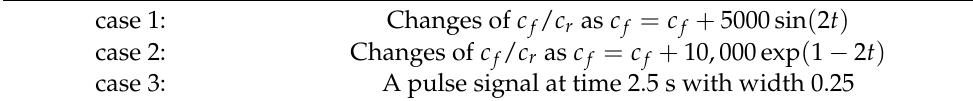
Table 4. Different external disturbances.